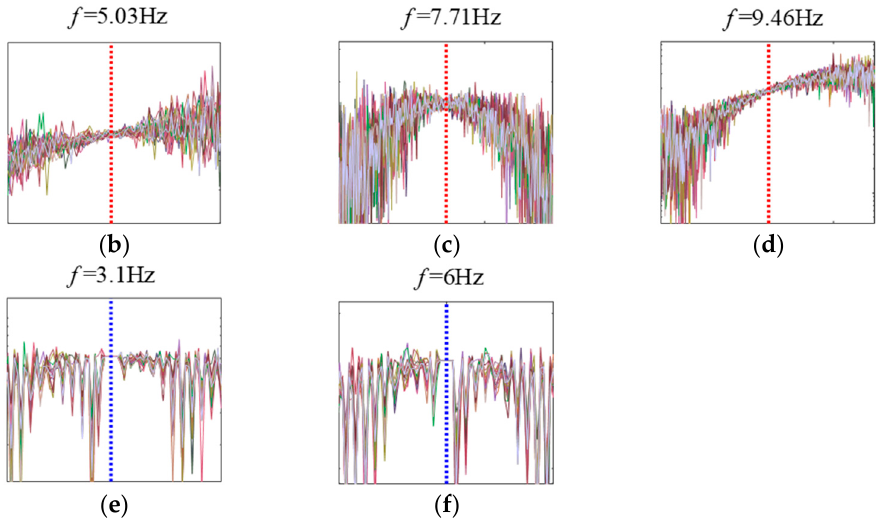
s : the 4th-order